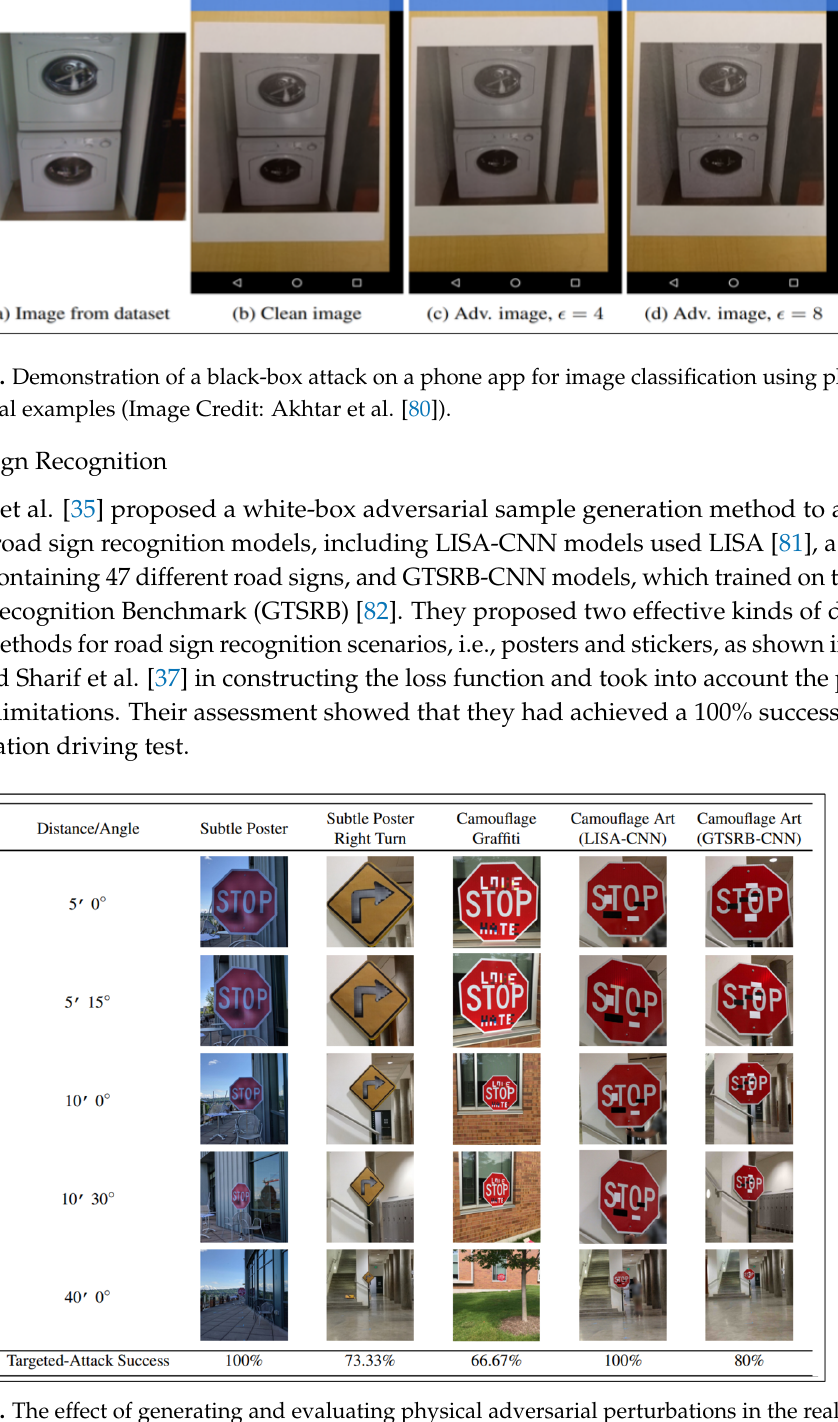
Figure 11. The effect of generating and evaluating physical adversarial perturbations in the real world (Image Credit: Eykholt et al.